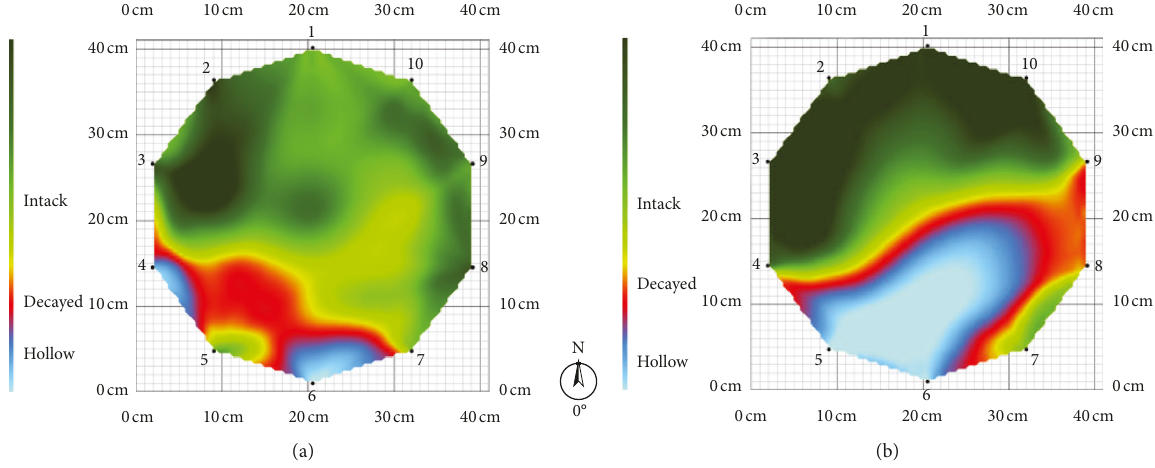
Figure 6: Internal damage of columns detected by stress wave testing instrument. Table 11: Comparison matrix and indexes weight of L